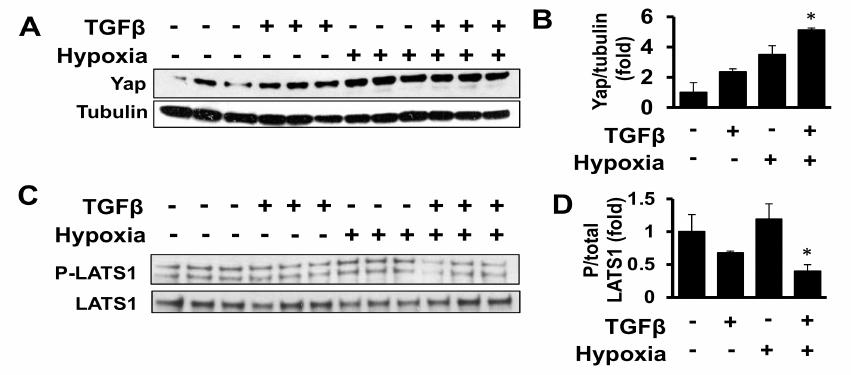
localization (left panel) and vimentin for fibroblast localization (right panel) in human LV cardiac tissues from non-failing (control) and patients with HF. Yap localization to cardiomyocytes and inter-cardiomyocyte areas are identified with yellow and white arrows, respectively. Images are representative from 3 subjects/group. Bar equals 50 µ m.